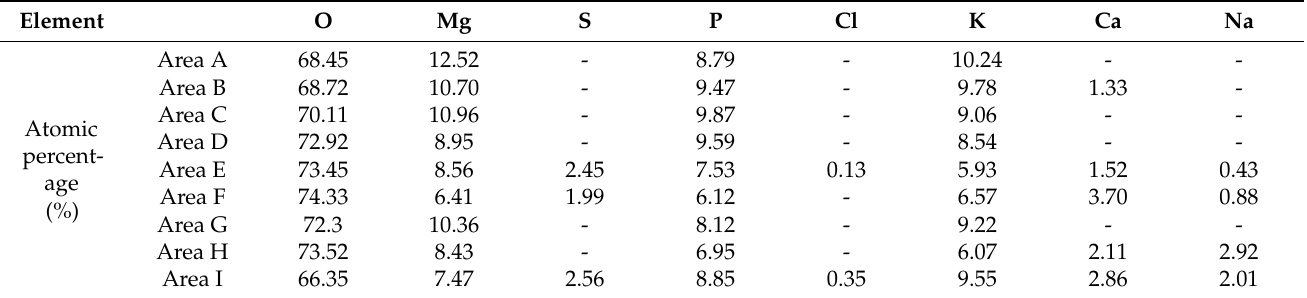
Table 4. Distributions of elements in different regions of the MKPC mortar samples.